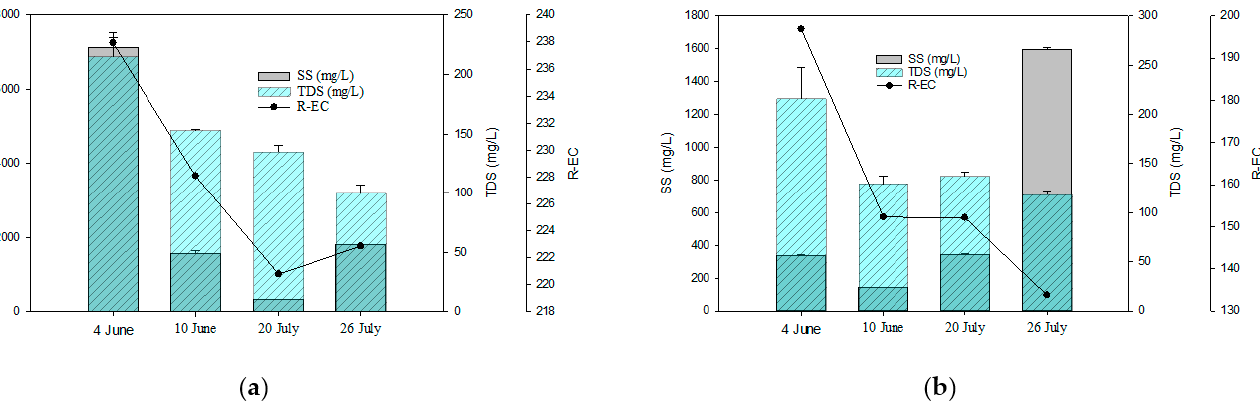
( b ) Figure 5. Changes in water quality at 4.5 m. ( a ) Changes in total heavy metal concentrations and ( b ) changes in dissolved heavy metal concentrations. Figure 6 shows that conductivity at 2.0 m was not positively correlated with heavy metal concentration. This result is also inconsistent with that in Figure 4b, which shows that the maximum TDS concentration occurred on 4 June. The dissolved heavy metal concentration on 4 June was also similar to that on other days. Therefore, in addition to